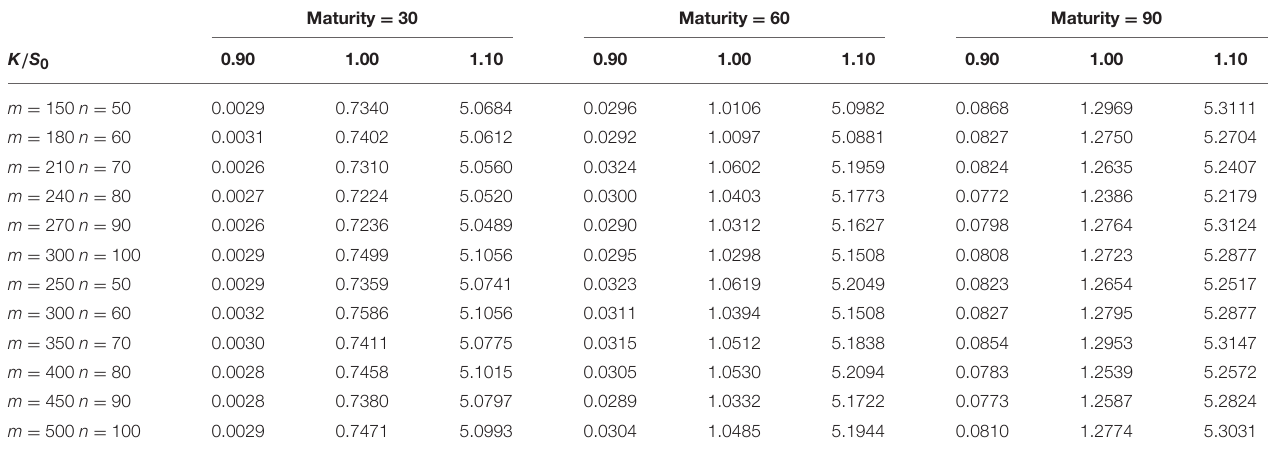
TABLE 1 | American put options in the CTS-GARCH framework.